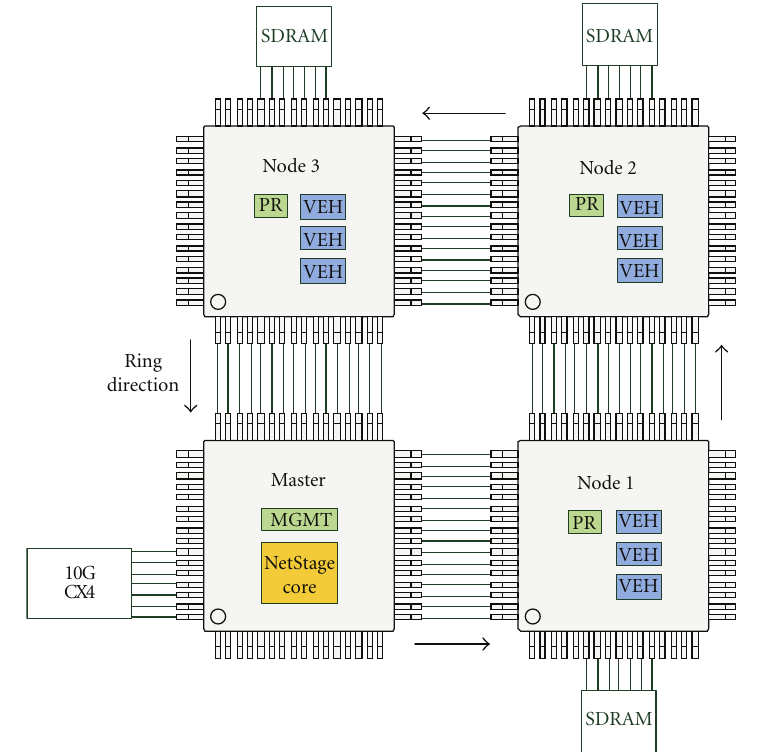
Figure 4: Multi-FPGA network processor in ring